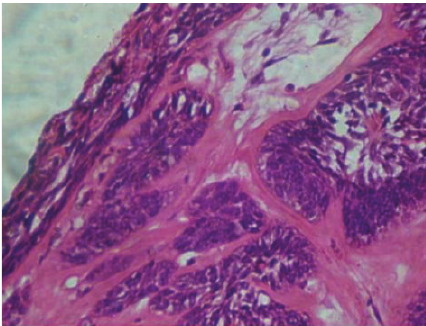
Figure 6: Squamous metaplasia of cystic lining and hyalinization of underlying connective tissue (H and E) 40x.